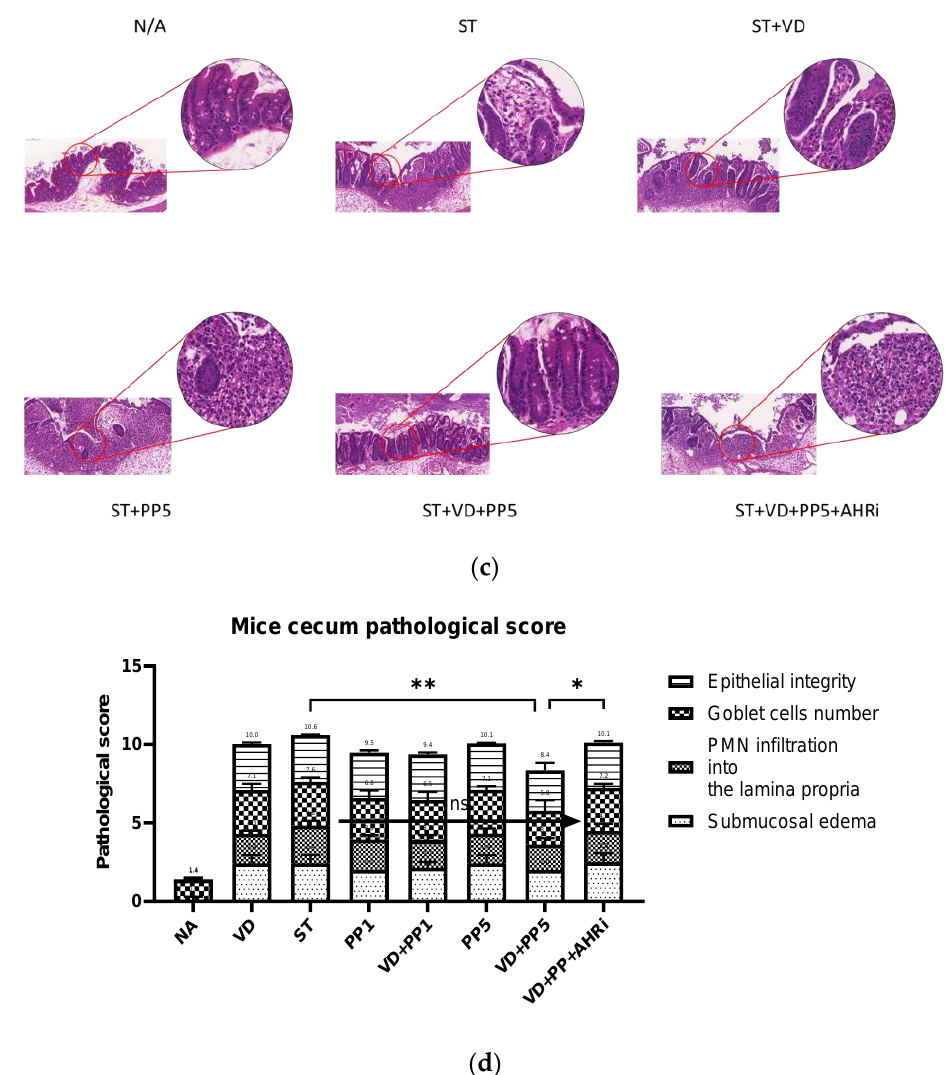
Figure 1. The involvement of AhR in the synergistic effects of PP on VD3-mediated attenuating the severity of Salmonella colitis in mice. Six–eight-week-old female C57BL/6 mice (Charles River, Wilmington, MA, USA) were bred and housed under specific pathogen-free conditions in the animal facility of the Center for Cellular and Biomolecular Research, Kaohsiung, Taiwan. Mice were treated or infected as in Materials and Methods and divided into the following groups: Control (NA), ST